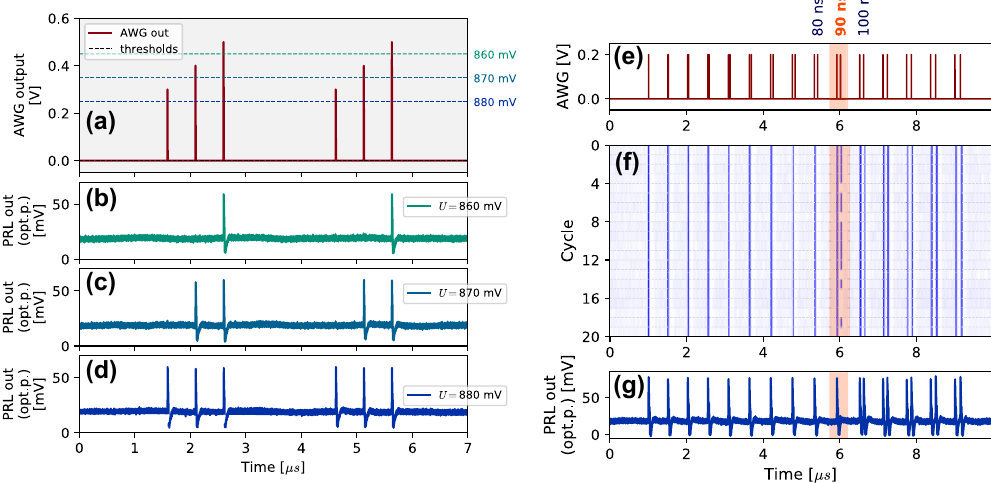
Figure 2: Threshold and refractoriness characterization in the PRL. (a) Source waveform of stimuli (3 ns square pulses) with varying amplitude. This serves as PRL input via MZM on the input branch to the PRL. Dashed lines show approximate threshold levels for different RTD bias voltages. (b)–(d) Timetraces of VCSEL output as recorded on an amplified photodetector. For the lowest bias voltage value, (b) U = 860 mV, the threshold is further from the steady state and only the strongest perturbation triggers a response (a spike). Response for same signal with RTD bias U = 870 mV, (c) and response with RTD biased closest to the threshold, for U = 870 mV (d); refractory period demonstration with temporal map ( n = 20 cycles); refractory period study: (e) the source modulation, consisting of pulse pairs with gradually increasing temporal separation (10 ns increments). (f) The temporal map shows the traces of 20 subsequently recorded measurement cycles of 10 μ s length. (g) Example of one response trace of the PRL